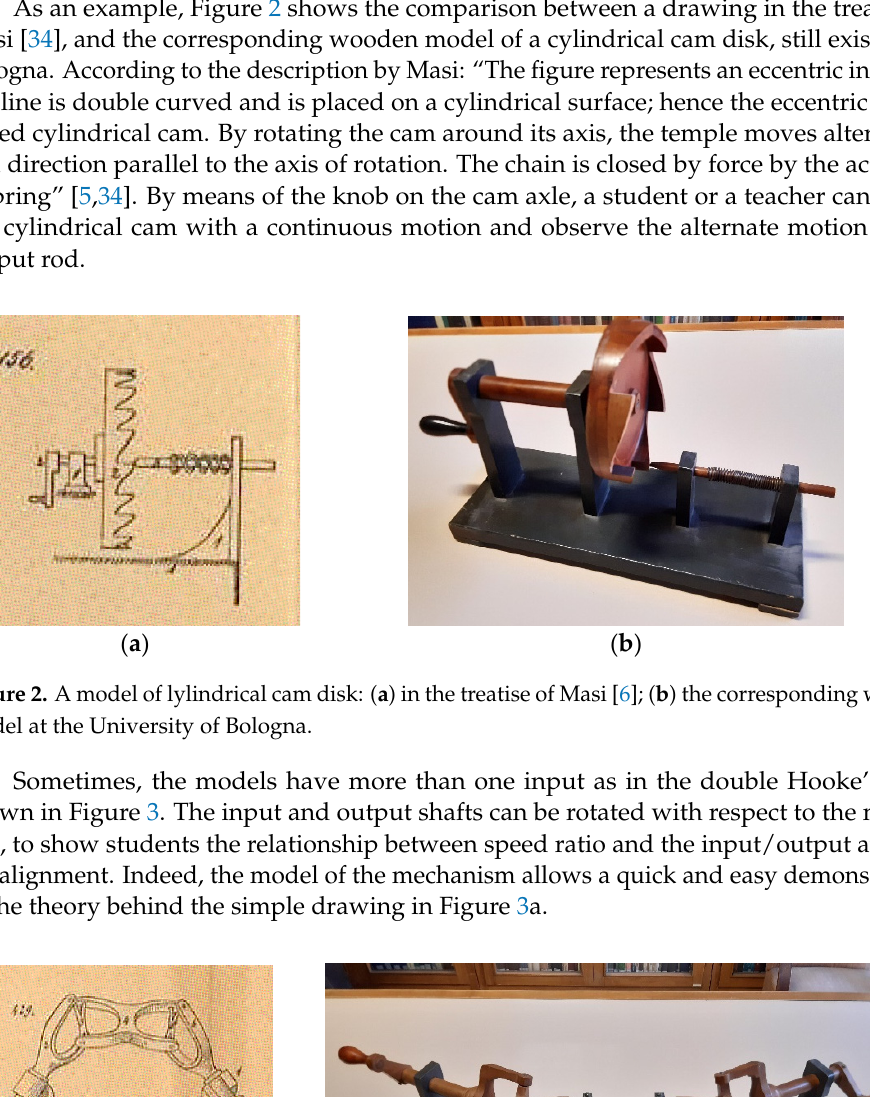
Figure 3. A model of the double Hooke’s joint: ( a ) in the treatise of Masi [34]; ( b ) the corresponding wooden model at the University of Bologna.